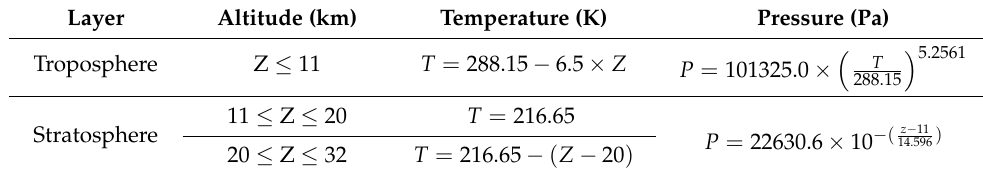
Figure 4. Evolution of the temperature with the altitude—ISA model. Table 1. Analytic standard atmosphere model used.